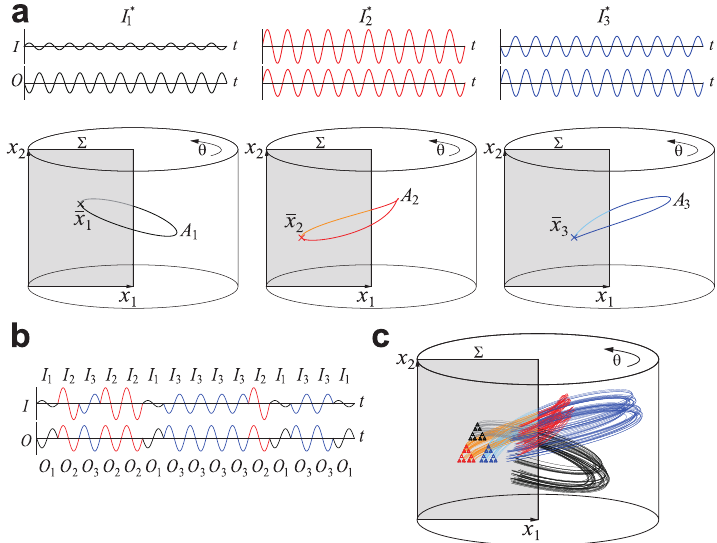
Figure 6. ( a ) Examples of time series for three periodic inputs. I and O denote the input and output time series, respectively. The trajectories for three periodic inputs in three-dimensional cylindrical phase space, ( x 1 , x 2 , θ ) ∈ M : R 2 × S 1 , corresponding to the colored trajectories denoted by A 1 , A 2 and A 3 cross the Poincaré section Σ : R 2 at ¯ x 1 , ¯ x 2 and ¯ x 3 , respectively. ( b ) An example of a time series for switching inputs. ( c ) The trajectories of randomly switching inputs and the cross points on the Poincaré section show the Sierpinski gasket as a result of the fractal transitions. Modified with permission from [39], Fractals 1999.